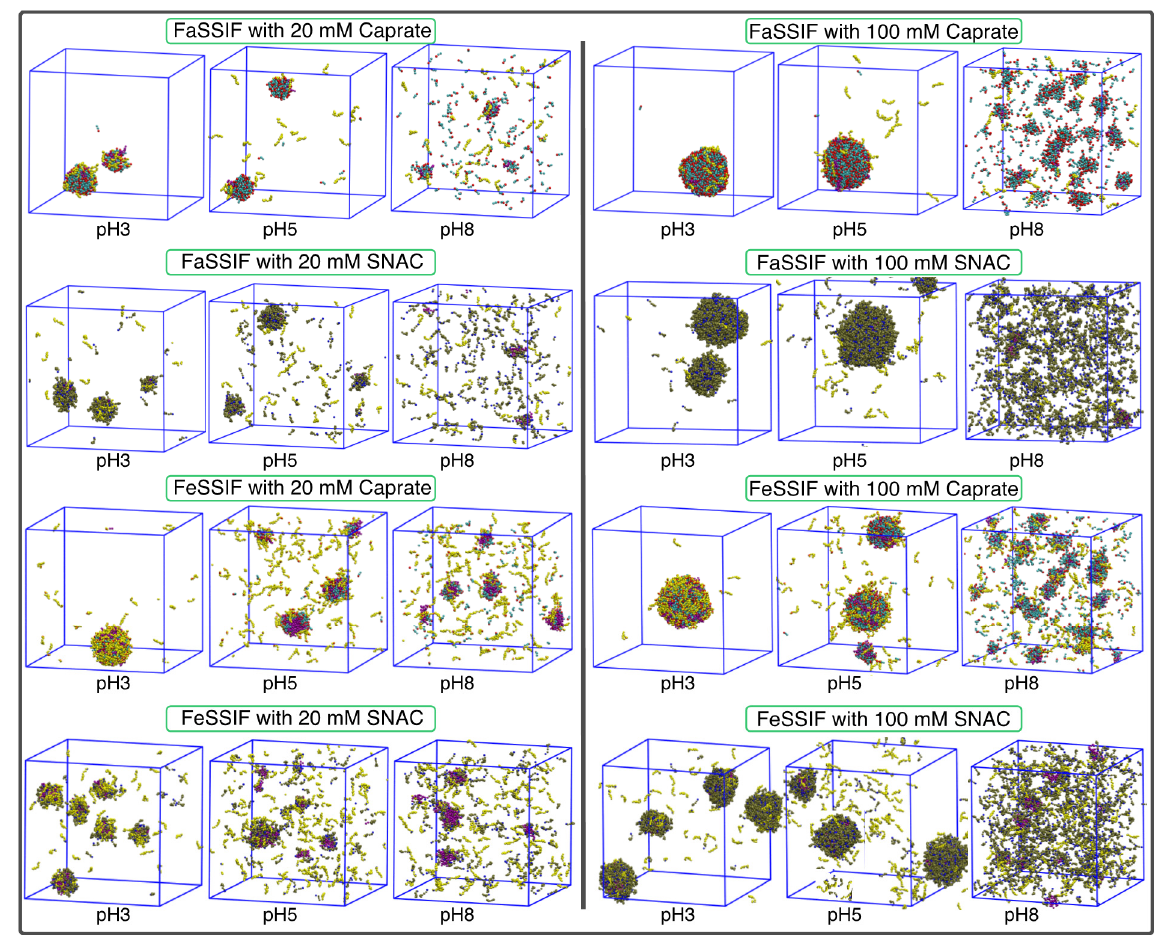
Figure 2. Snapshot of each simulation system at 1 µs. Taurocholate and DLiPC molecules are represented by yellow and purple beads, respectively. Caprate molecules are represented by cyan and red beads, representing the fatty acid tail and headgroup, respectively. Similarly, SNAC molecules are represented by tan and blue beads, representing the tail and headgroups, respectively.